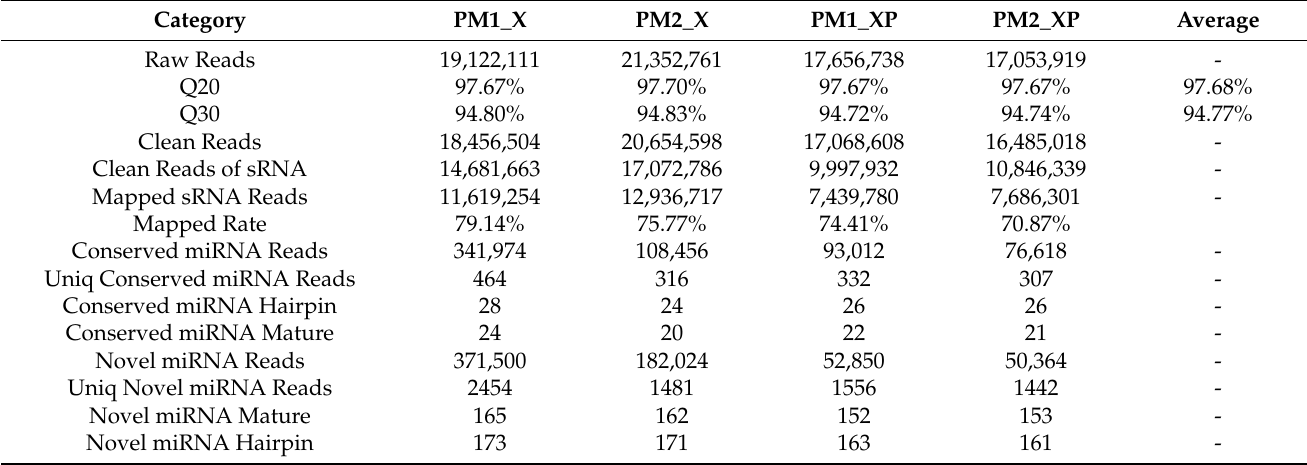
Figure 1. RNA quality of the developing xylem (PM_X) and protoplasts isolated from developing xylem (PM_XP). Table 1. Summary of sRNA sequencing data from four RNA libraries in the developing xylem (PM_X) and protoplasts isolated from developing xylem